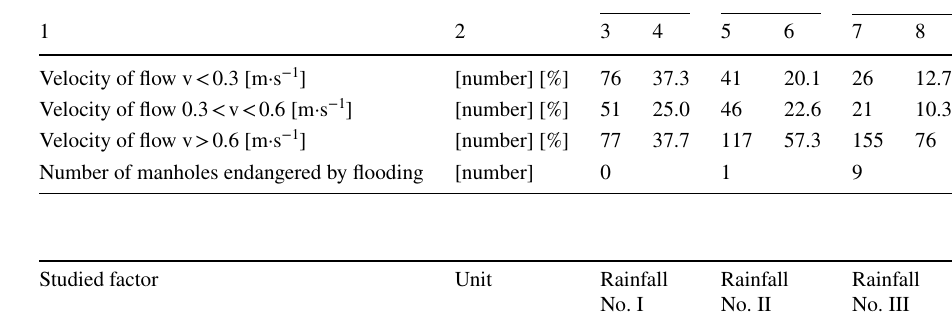
Table 4 Results of numerical calculations for different rainfall events – real catchment